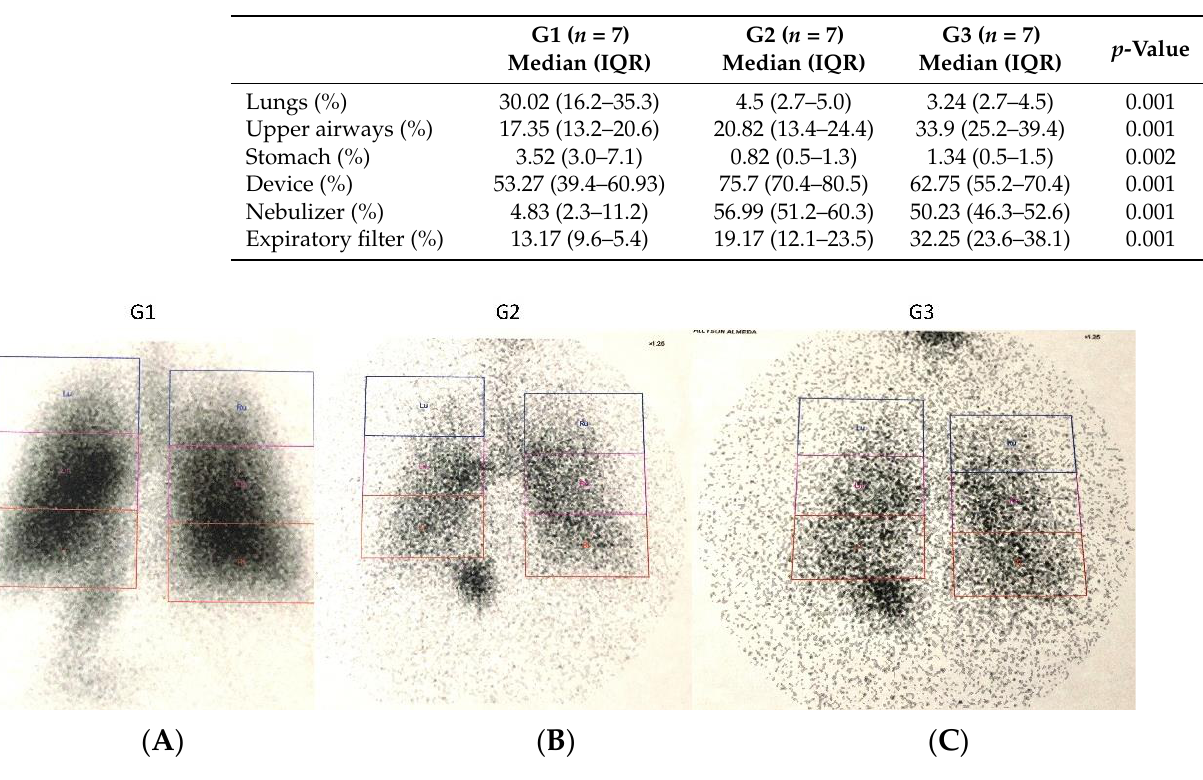
Figure 3. Pulmonary and extrapulmonary ROIs that are used to quantify aerosol deposition and calculated the mass balance across compartments including ( A ) total lung regions, ( B ) stomach, ( C ) upper airways, ( D ) nebulizer, adapter and expiratory filter. Table 2. Median and interquartile range (IQR) of aerosol deposition measured in the lungs, upper airways, stomach, the device (including nebulizer, VHC or T-piece), nebulizer alone, and expiratory filter. (G1: mesh nebulizer with VHC, G2: Jet nebulizer with VHC, G3: Jet nebulizer alone).